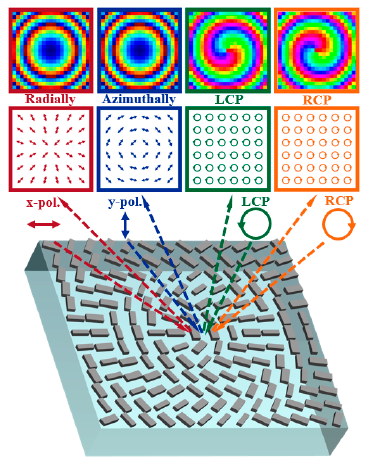
Figure 1. Schematic diagram of the function of reflective metasurfaces.